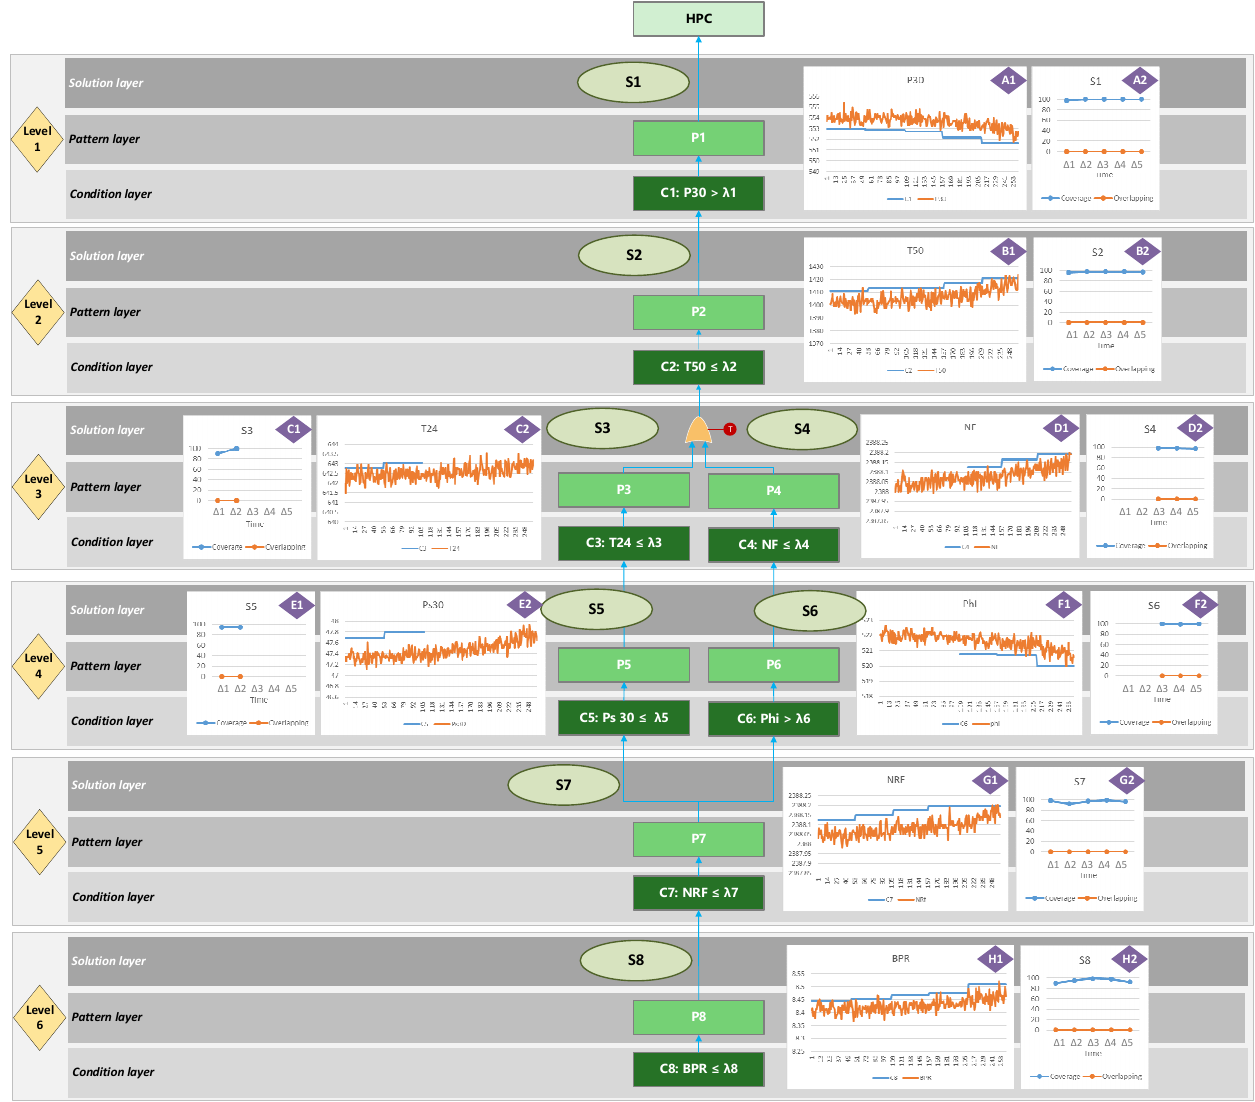
Figure 8. Obtained ITCA model of the HPC degradation mode.